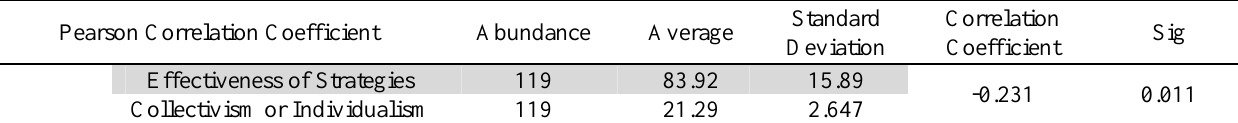
Standard Correlation Deviation